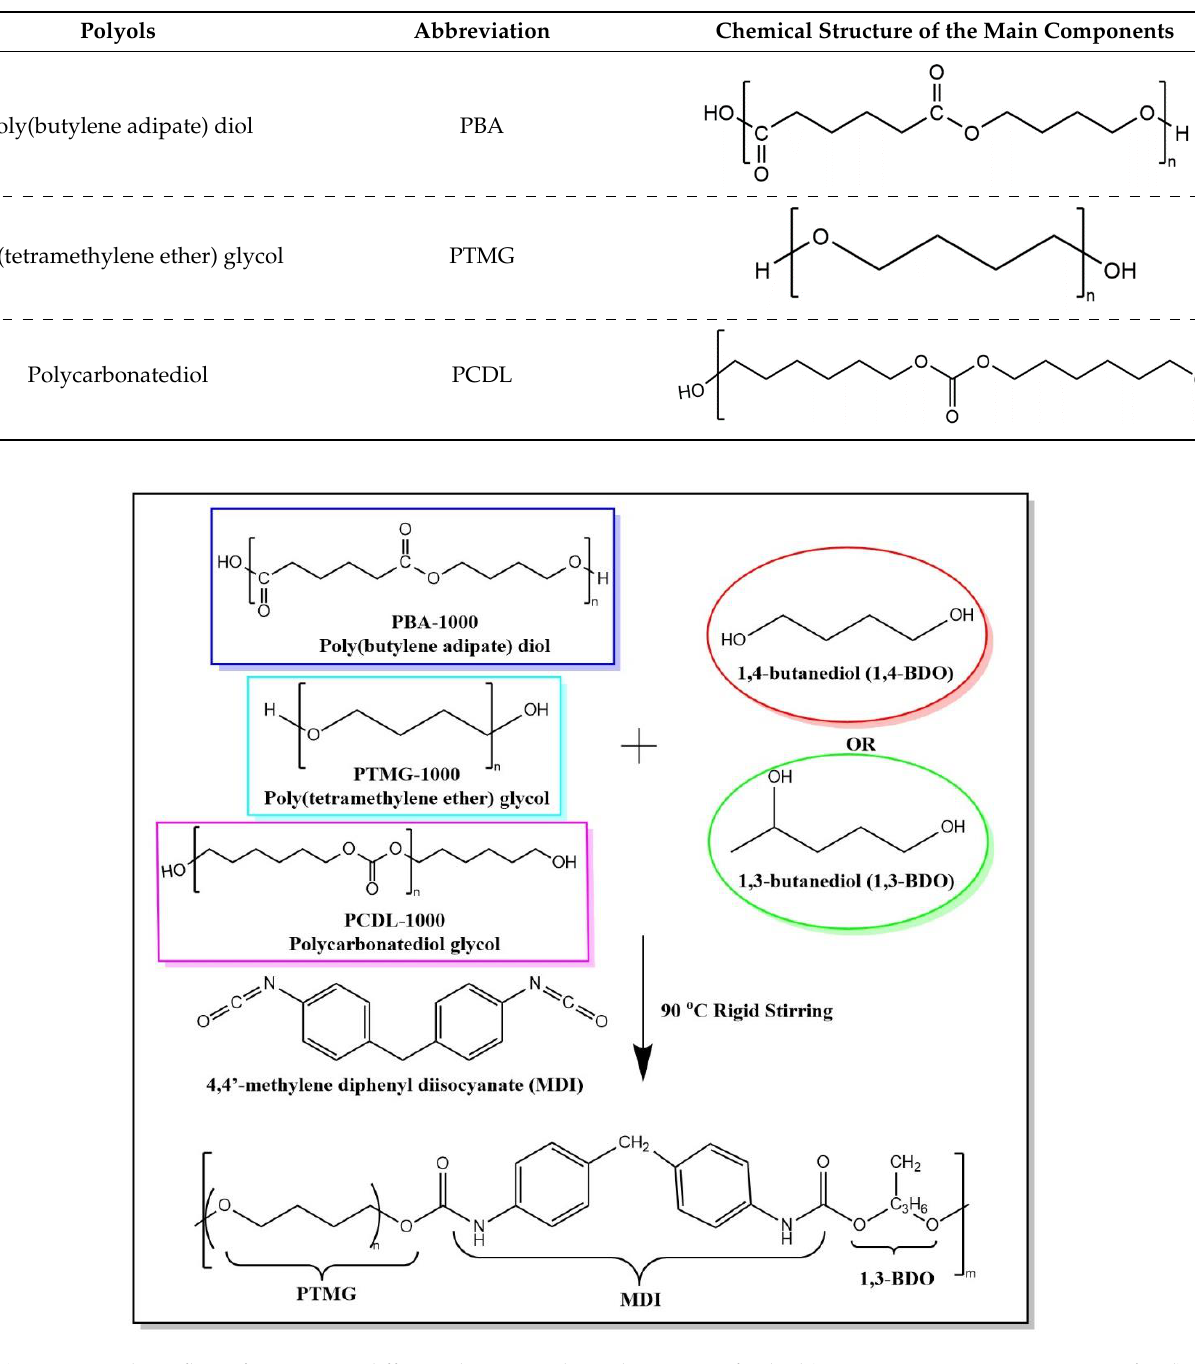
Table 1. The types of polyol used in synthesizing thermoplastic polyurethanes